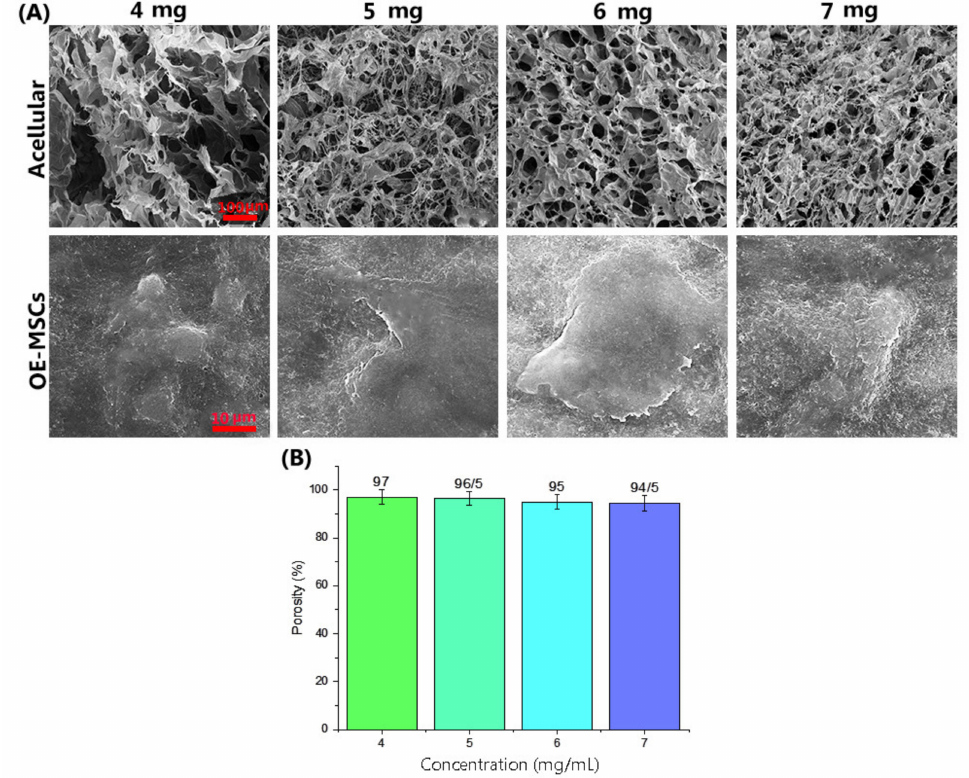
Figure 4. ( A ) FE-SEM images of the collagen hydrogel structures with different concentration of collagen (Scale bar: 100 µ m) and OE-MSCs encapsulated in different concentration of collagen hydrogel (Scale bar: 10 µ m); ( B ) The porosity percentage of collagen hydrogel scaffolds in different collagen concentrations, including 4 mg/mL, 5 mg/mL, 6 mg/mL, and 7